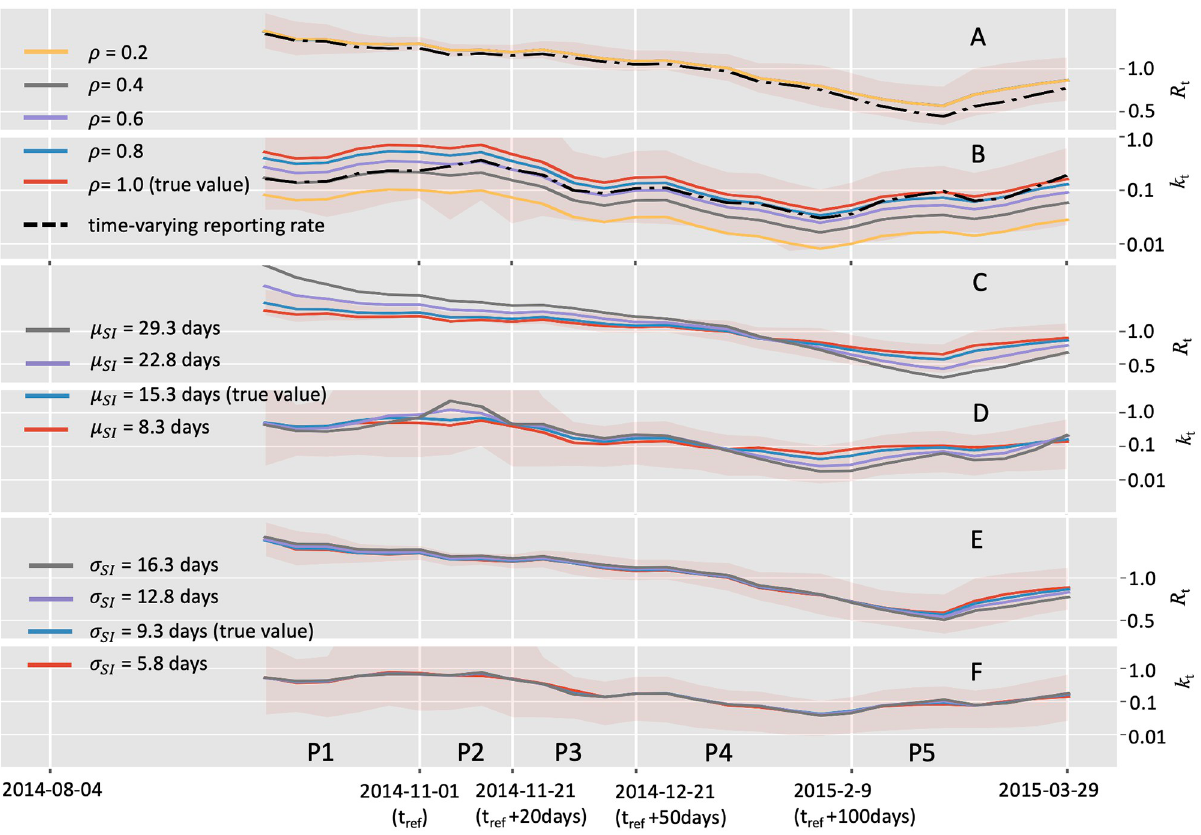
Fig 6. Effects of underreporting rates and misspecification of the serial interval on estimating transmission dynamics with the instant-individual heterogeneity model. Synthetic data incorporating missing cases were generated on the basis of the incidence data from the Ebola epidemic between Aug 04, 2014 (week 36), and March 29, 2015 (week 13), in the capital Freetown of Sierra Leone. Colored lines show the mean estimates and the shaded areas show the 95% high probability density intervals under the true values. A and B: Estimation under different reporting rates ( ρ ). Dashed lines represent the estimates under the scenario with time-varying reporting rate. C and D: Estimation from different specification of the serial interval mean ( μ SI ); E and F: Estimation from different specification of the serial interval standard deviation ( σ SI